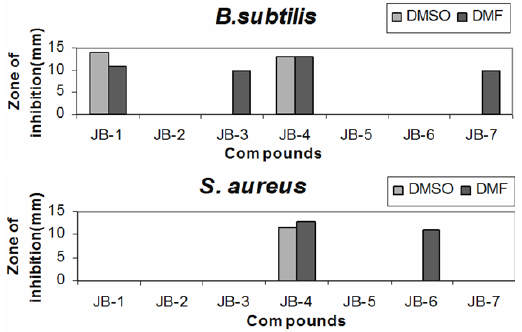
Figure 1: Antibacterial activity of azomethines against Gram positive bacteria in DMSO and DMF.